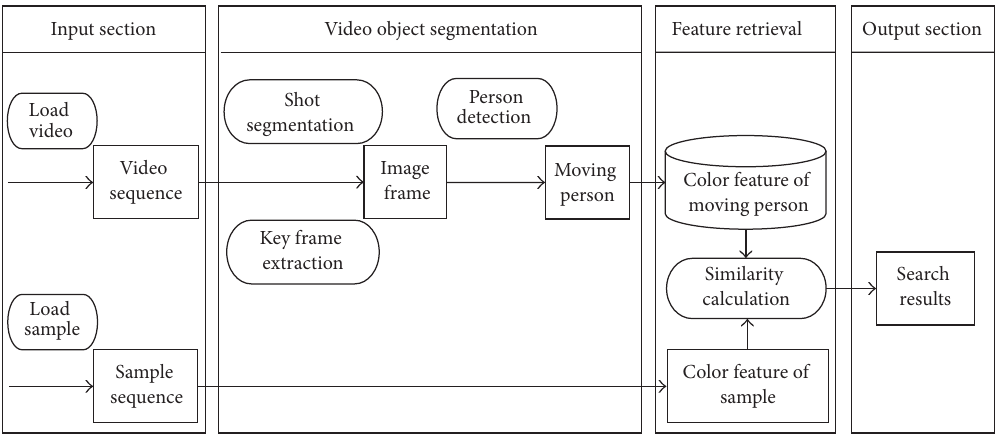
Figure 2: Overview of the